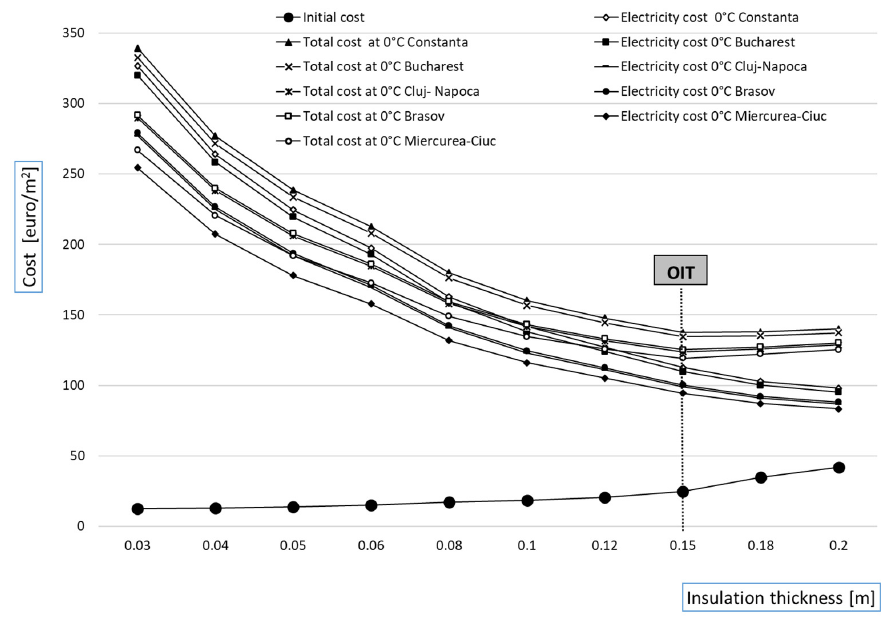
Figure 4. OIT for cold storage .